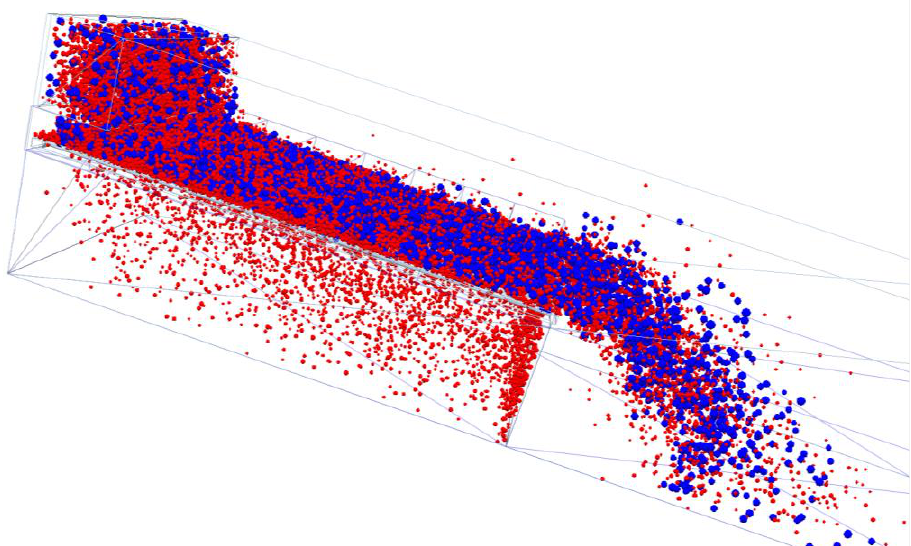
Figure 5. The screening process of the concrete particles.